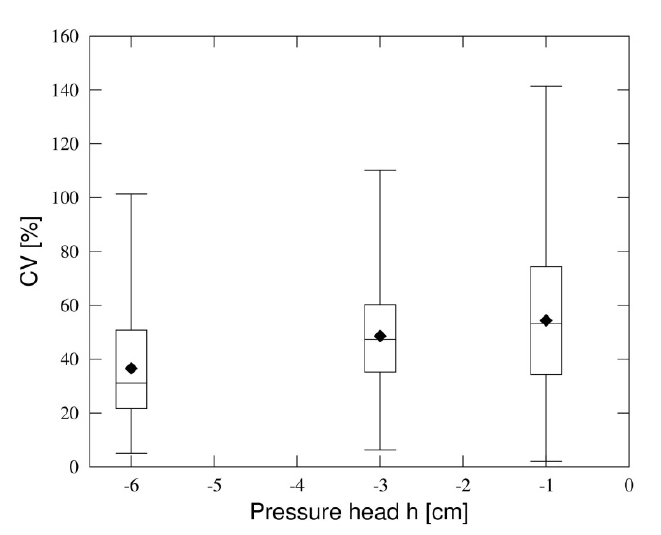
Fig. 3. Distributions of coefficient of variation (CV, %) in near-saturated hydraulic conductivity (K( h )) measured within a field plot either simultaneously or over a few successive days of similar conditions. Arithmetic means are indicated by diamonds, whereas the boxes denote medians and lower and upper quartiles, and the whiskers minimum and maximum values. n = 38 for pressure head (h) = −6 cm, n = 44 for h = −3 and −1